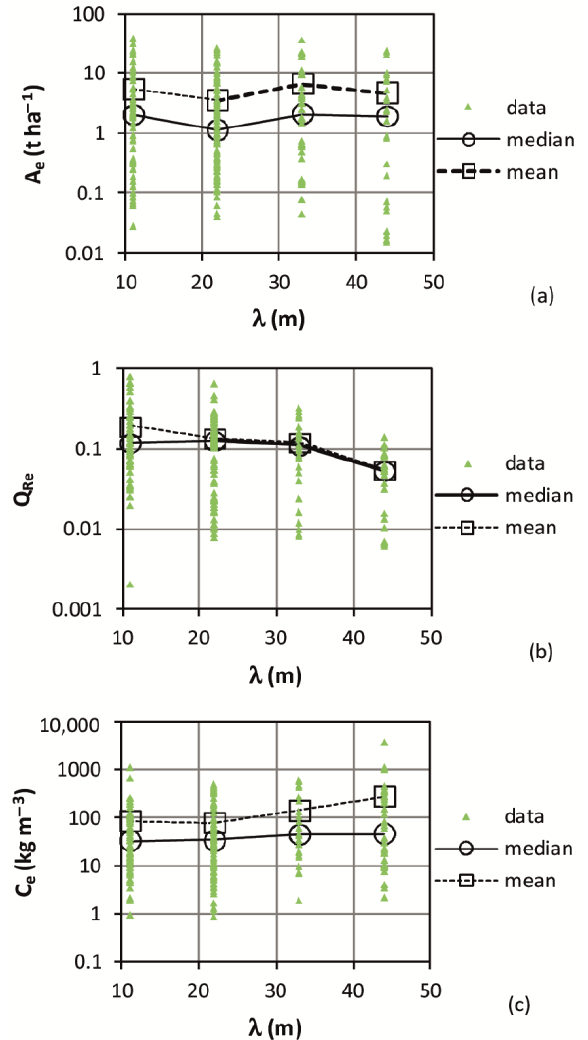
Figure 6. Plot length, λ, effect on event ( a ) soil loss per unit area, A e , ( b ) runoff coefficient, Q Re , and ( c ) sediment concentration, C e , for the plots with slope steepness s = 14.9% (modified from [30]).